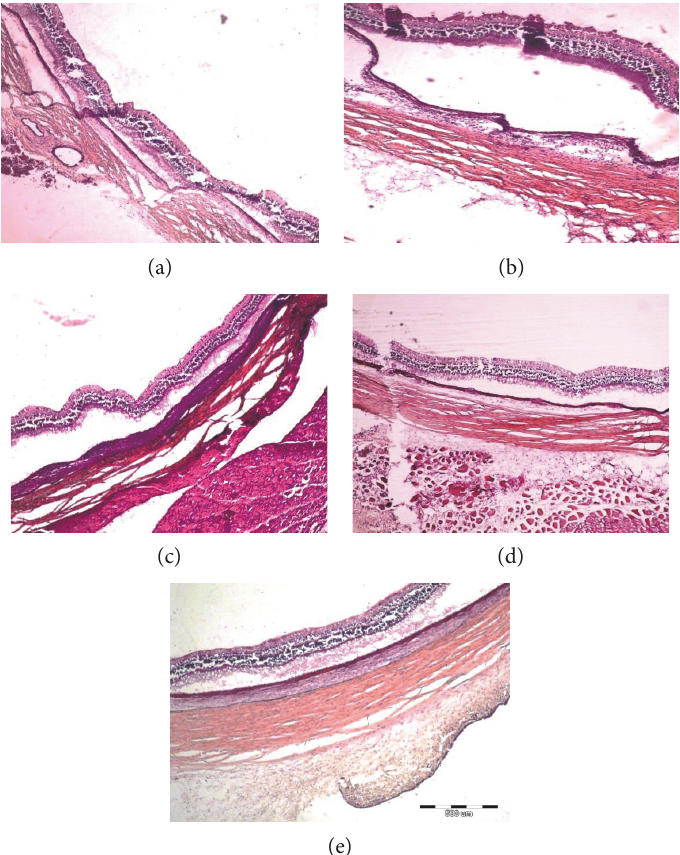
Figure 5: Histopathology analysis of transplanted eyes. Representative images of frozen sections of rabbit eyes removed from control nontransplanted eyes (a) or eyes removed 2 hours (b), 4 days (c), 2 weeks (d), or 10 weeks (e) following transplantation of hBMSCs were stained with hematoxylin-eosin. No in fl ammatory cells or hemorrhages were detected. Scale bar 500 μ